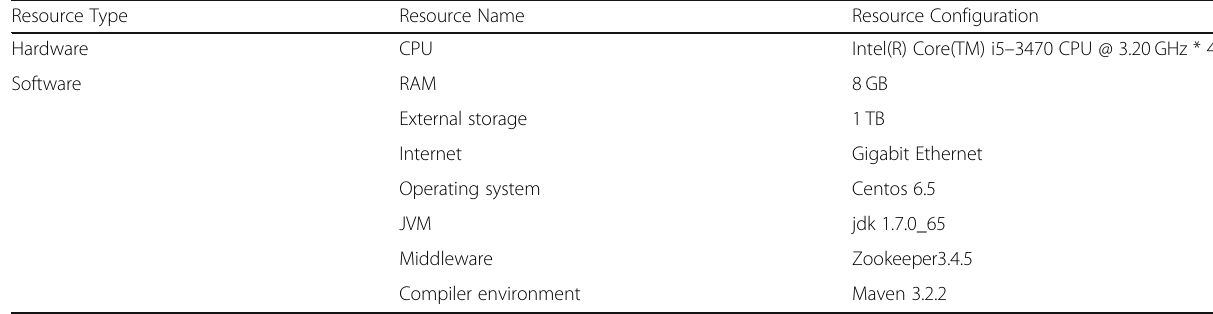
Table 1 Test environment configuration Resource Type Resource